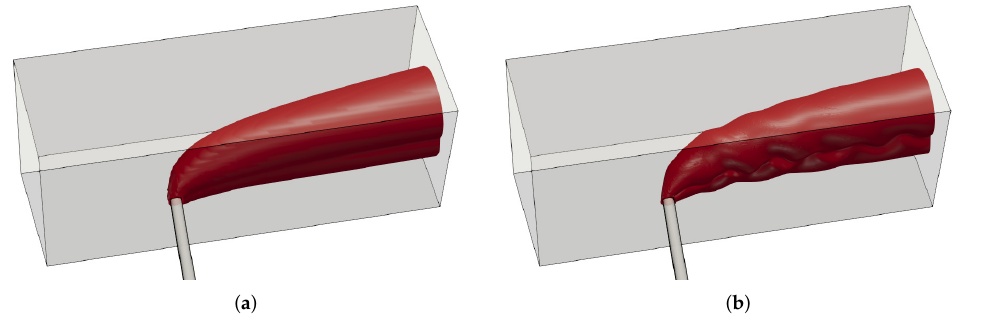
Figure A3. Jet shape for the SST model where c = 0.01: ( a ) results on the initial grid used for AMR